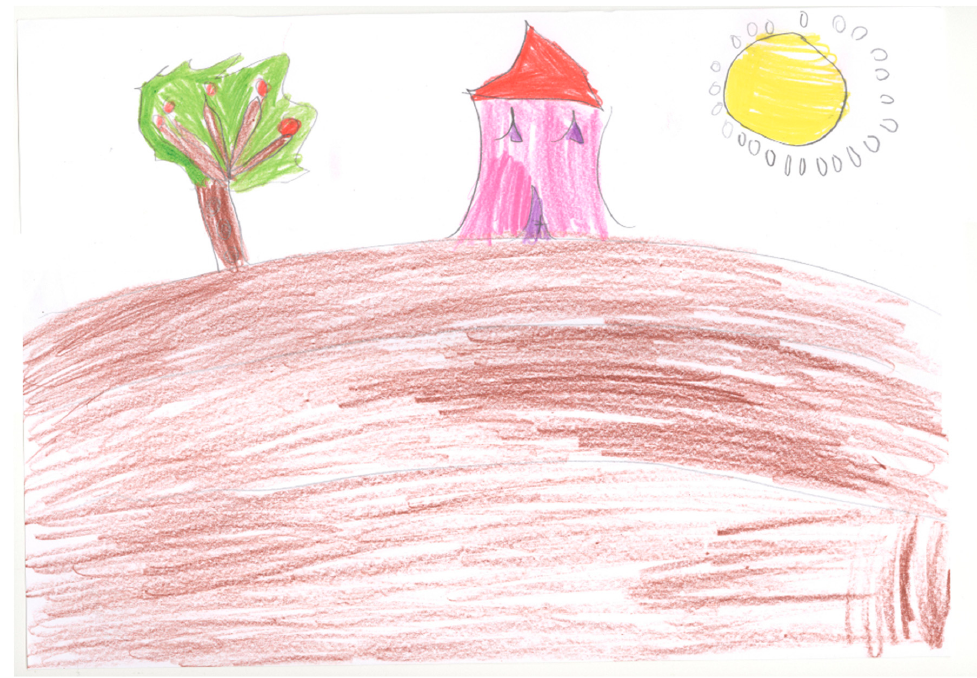
Figure A2. A spontaneous drawing depicted by a 6-year-old child.